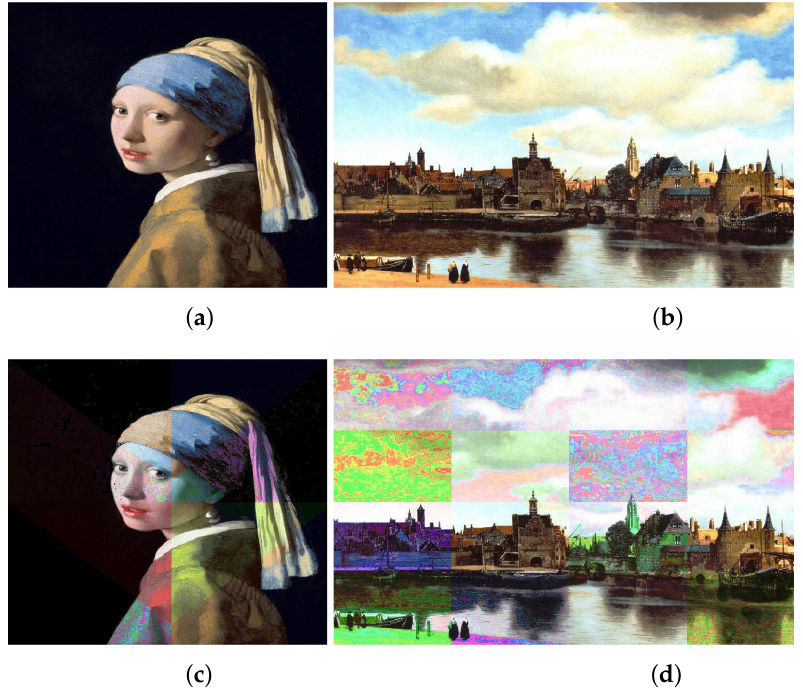
Figure 5. Johannes Vermeer (1632–1675): ( a ) Girl with a Pearl Earring , 1665. ( b ) View of Delft , 1661. The same Vermeer painting with color symmetry imposed by a color permutation. ( c ) Triangular pattern. ( d ) Chess board pattern with 16